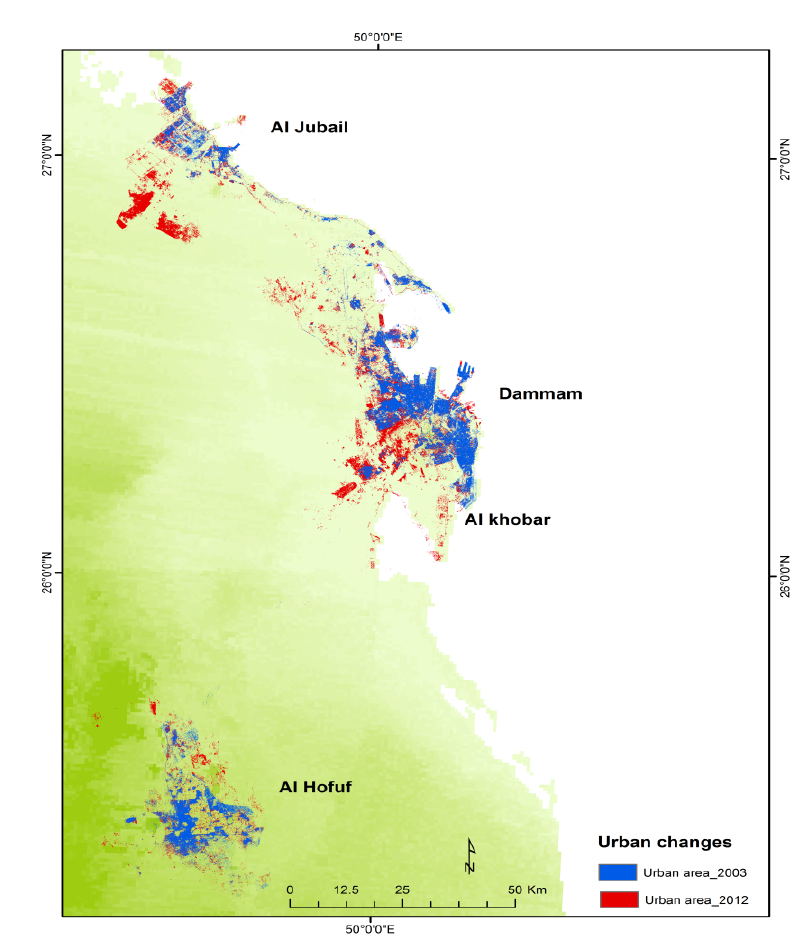
Figure 4. Urban expansion in area the East Area.